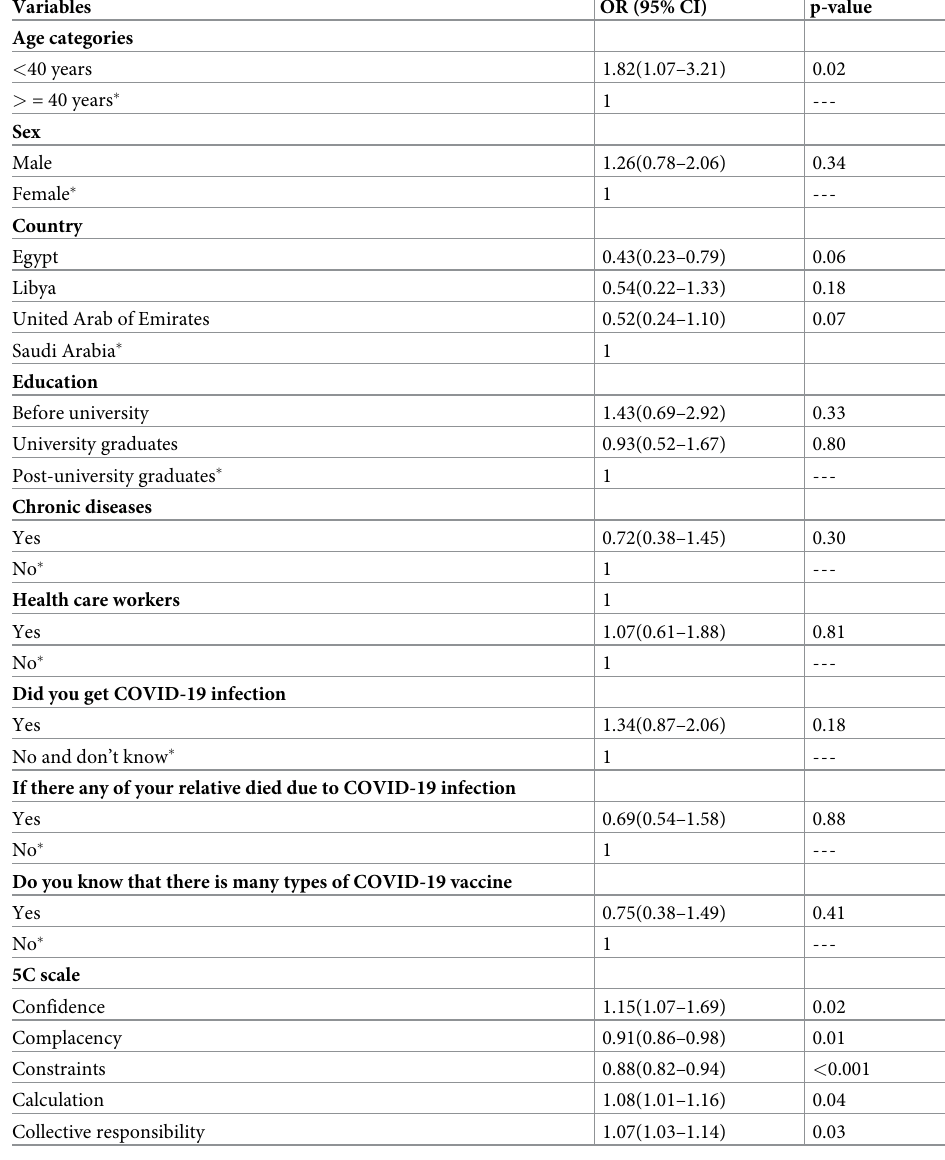
Table 3. Predictors of intention to get COVID-19 vaccine among the study